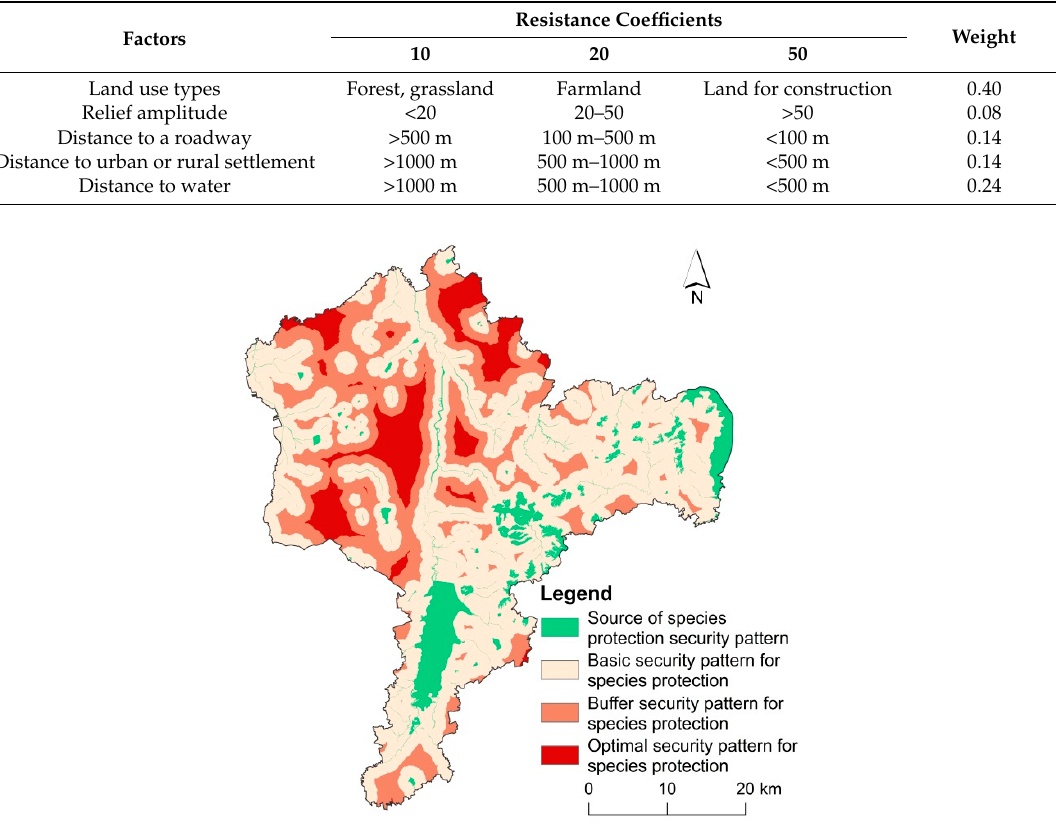
Table 4. Resistance coefficients and weights of resistance factors for recreation activities.